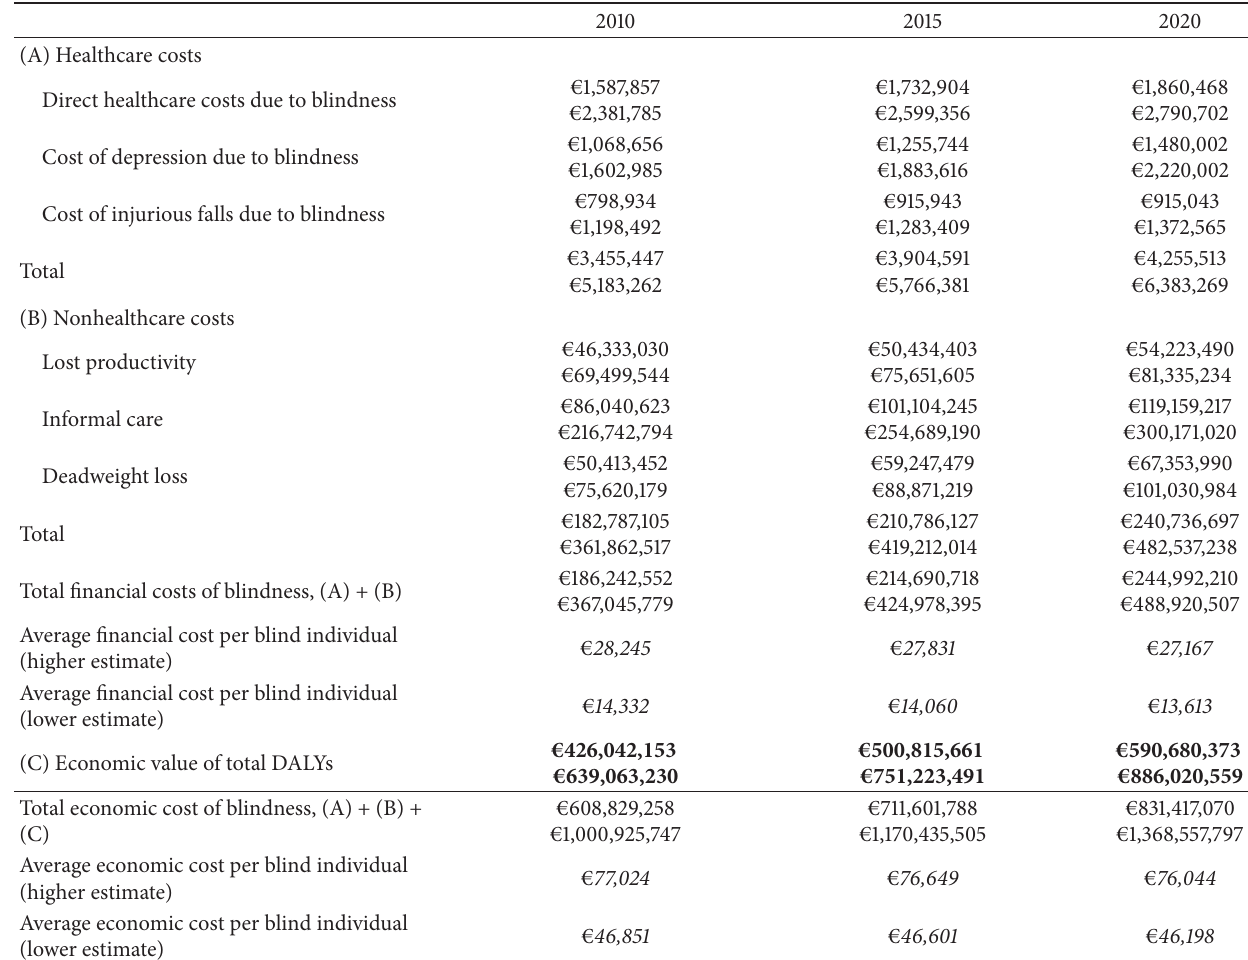
Table 5: Sensitivity analysis 2010–2020. The table illustrates the upper (+20%) and lower ( − 20%) limits around each point estimate. For informal care costs, €21.79 (average hourly wage in 2010) is used as the higher estimate and €8.65 (minimum hourly wage in 2010) is used as the lower estimate of the cost per hour of informal care provided. The effect of reducing deadweight welfare losses to 9% gives the lower estimate for this parameter. This table thus provides a range and a mean or “likely” figure for the costs associated with